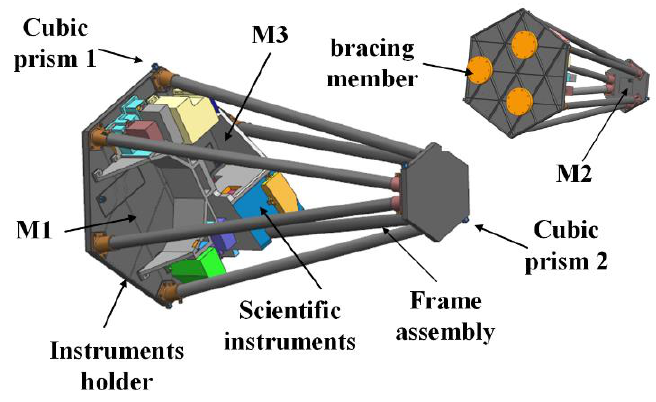
Figure 1. A typical model of an off-axis space telescope truss structure.